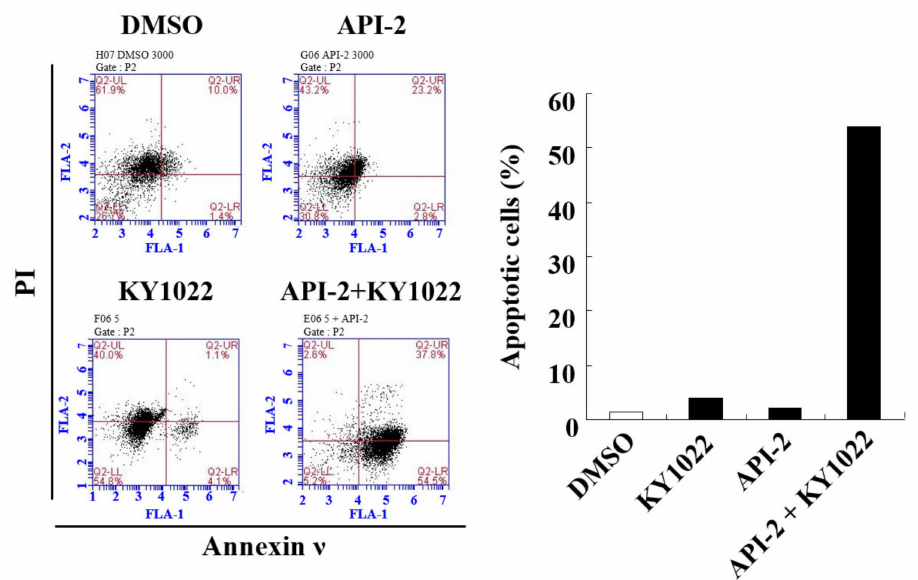
Figure 4. Effects of KY1022 on the API-2-induced resistance of the apoptosis in CRC cells. For each treatment of DMSO, API-2 (10 µ M), KY1022 (20 µ M), and the combination treatment, the flow cytometry analyses of the LoVo cells were stained with PI and annexin ν using a BD Accuri TM flow cytometer ( left ). Percentage of the early apoptotic cells expressing annexin ν and not expressing PI were quantified ( right